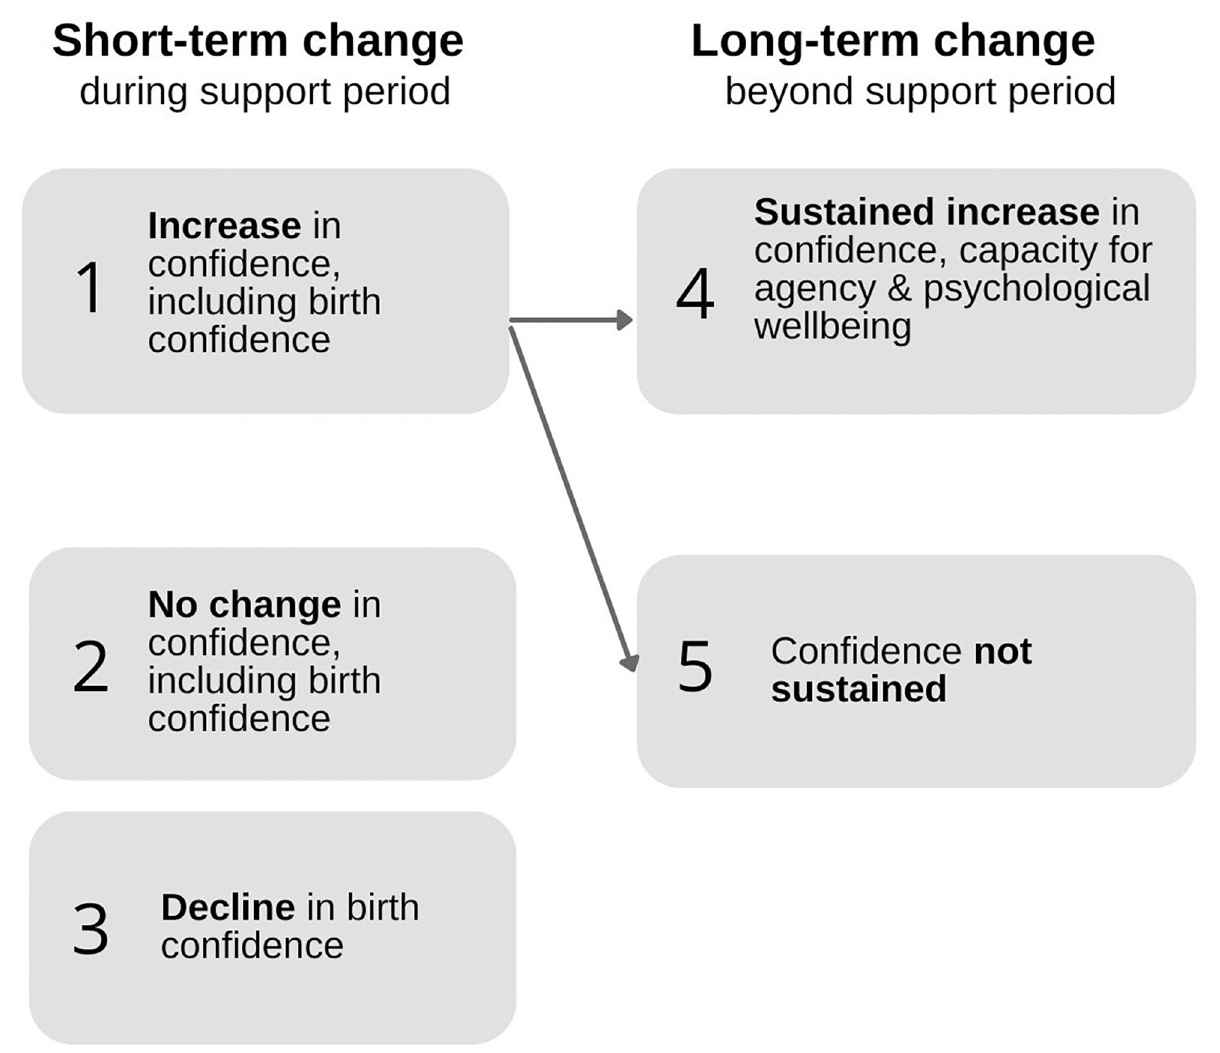
Fig 3. Short- and long-term confidence-related outcomes for women.